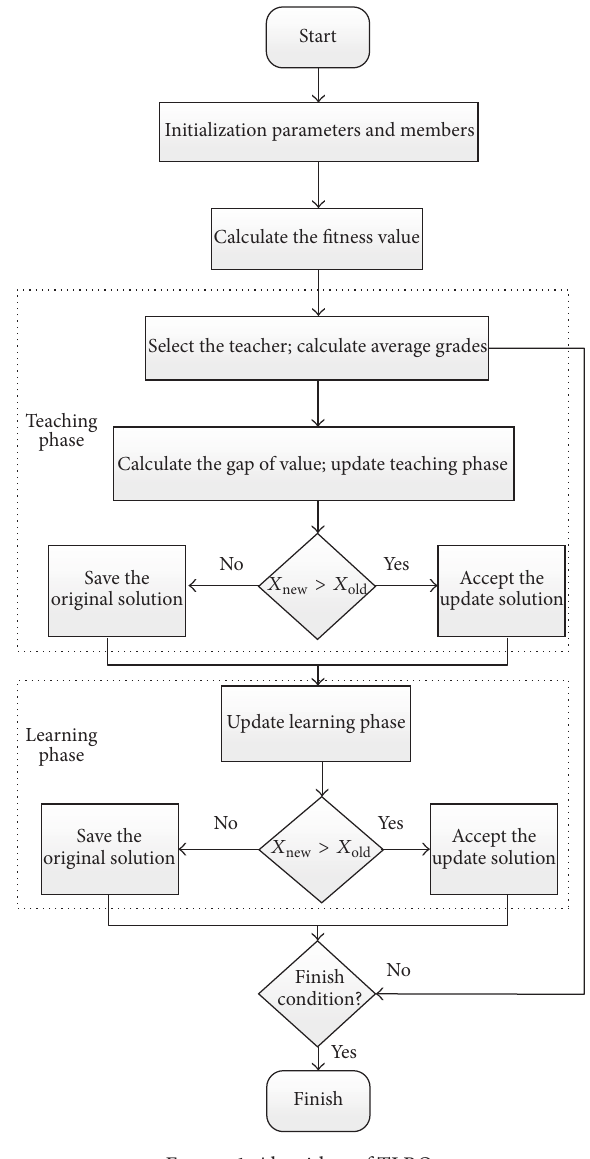
Figure 1: Algorithm of